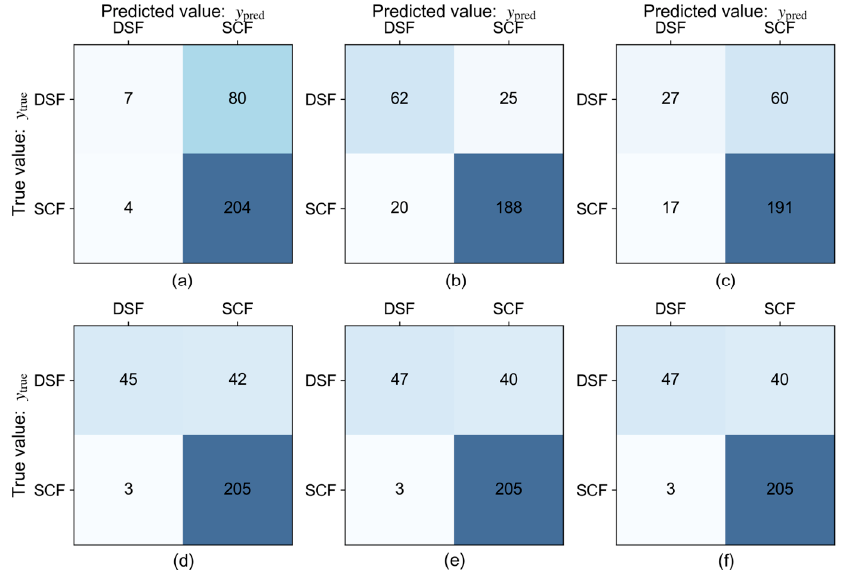
) based on the total dataset. ( a ) SVM; ( b ) DT; ( c ) (cid:3178) t (cid:3178)